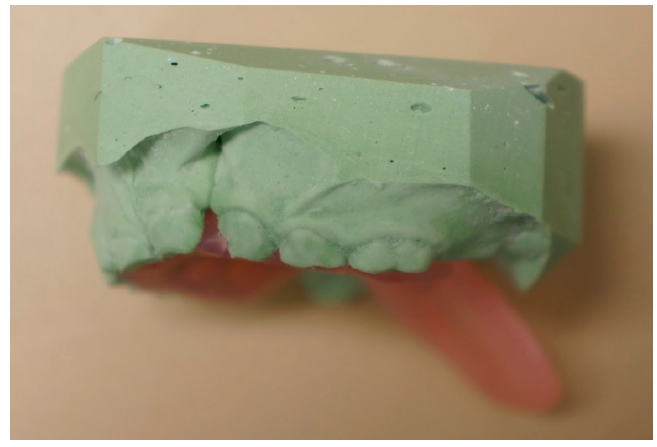
Figure 2. Lateral view of dental impression with the posterior extension of the PPS to cover pharyngeal flap.